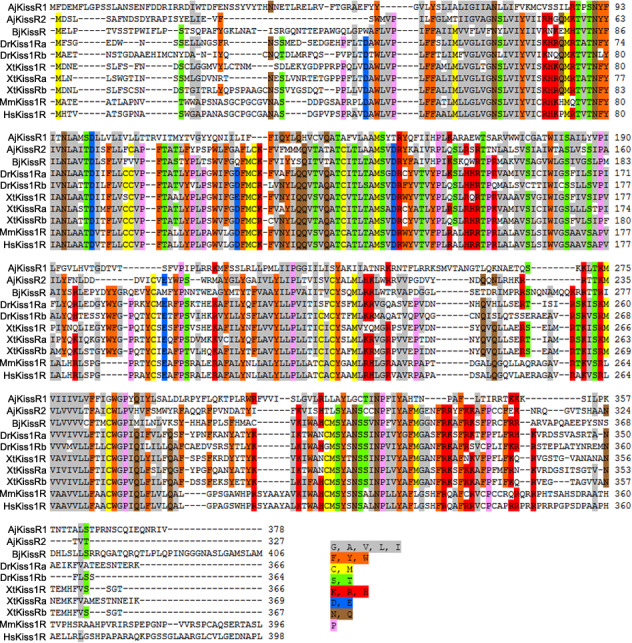
Alignment of the deduced Apostichopus japonicus kisspeptin receptor amino-acid sequences with functionally characterized chordate GPR54 molecules from other species.Sequences of Branchiostoma japonicum kisspeptin receptor (BjKissR), Danio rerio kisspeptin receptors (DrKiss1Ra NP_001099149.2 and DrKiss1Rb NP_001104001.1), Xenopus tropicalis kisspeptin receptors (XtKiss1R NP_001163985.1, XtKissRa NP_001165296.1 and XtKissRb NP_001165295.1), Mus musculus kisspeptin receptor (MmKiss1R NP_444474.1), and Homo sapiens kisspeptin receptor (HsKiss1R NP_115940.2) were obtained from GenBank. Alignment was conducted using CLUSTAL W and the color align property was generated using Sequence Manipulation Suite online. The percentage of sequences that must agree for identity or similarity coloring was set as 60%.